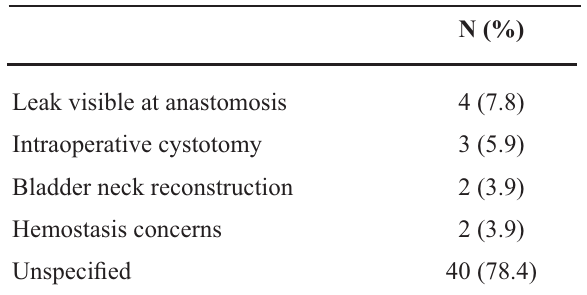
Table 3 – Indications for drain placement.